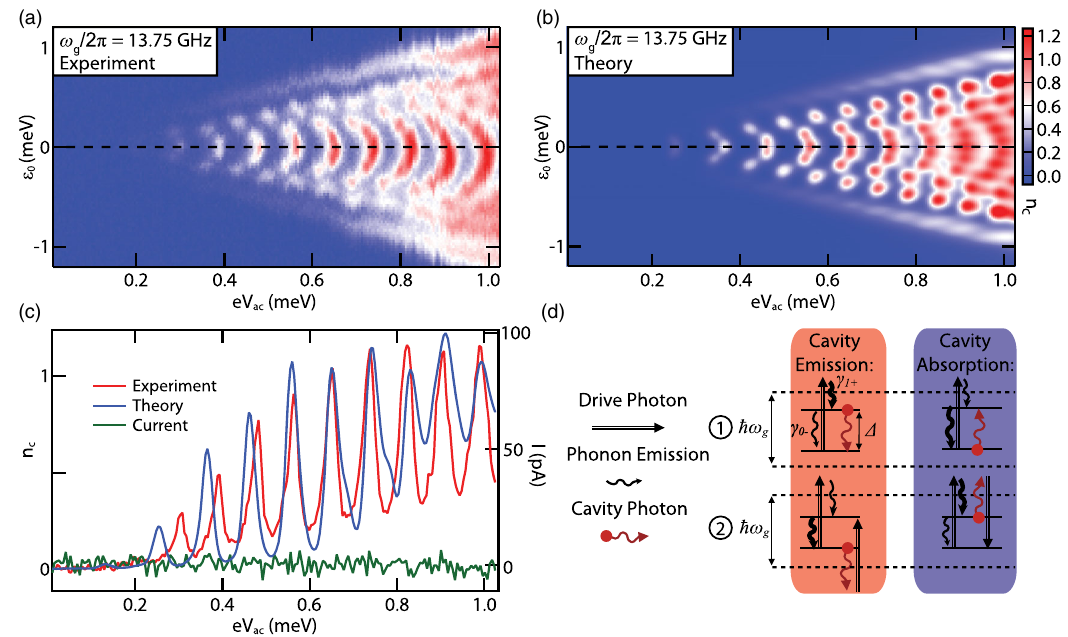
FIG. 3. (a) Photon number interference. n measured as a function of ϵ 0 and eV with no cavity drive. (b) Calculated n as a function c c ac of ϵ 0 and eV , showing good qualitative agreement with the data. Panels (a) and (b) are plotted using the same color scale. (c) Measured ac and calculated n as a function of eV for ϵ 0 ¼ 0 . Overlaid is the measured current I through the DQD. Notice that while photons are c ac being emitted, no dc current is detected. (d) Energy level diagrams for emission and absorption peaks. There are two configurations in which population inversion and photon emission occur. In the first case [labeled as (1)], the quasienergy splitting Δ ¼ ℏ ω and the DQD c − ℏ ω can directly emit a cavity photon. In the second case [labeled as (2)], Δ ¼ ℏ ω and the DQD can simultaneously absorb a drive g c photon and emit a cavity photon. The equilibrium population is determined by a competition between drive-assisted phonon emission that relaxes or excites the DQD in the Floquet basis at the rates γ and γ , respectively. Here n denotes the number of energy quanta n − n þ . Dominant phonon absorbed from the drive (see discussion surrounding Eq. 6). The schematic illustrates the processes γ 0 − and γ 1 þ relaxation processes are indicated by the bolder arrows in the